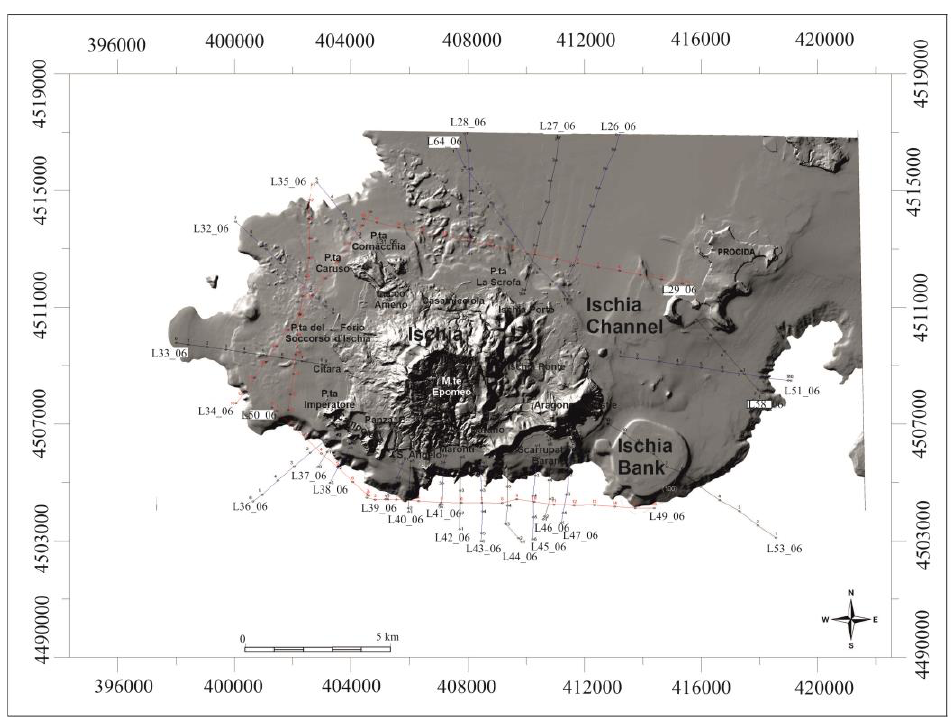
Figure 3. Ischia Digital Elevation Model with the location of the Sparker seismic profiles (modified after Sbrana et al. [56]).